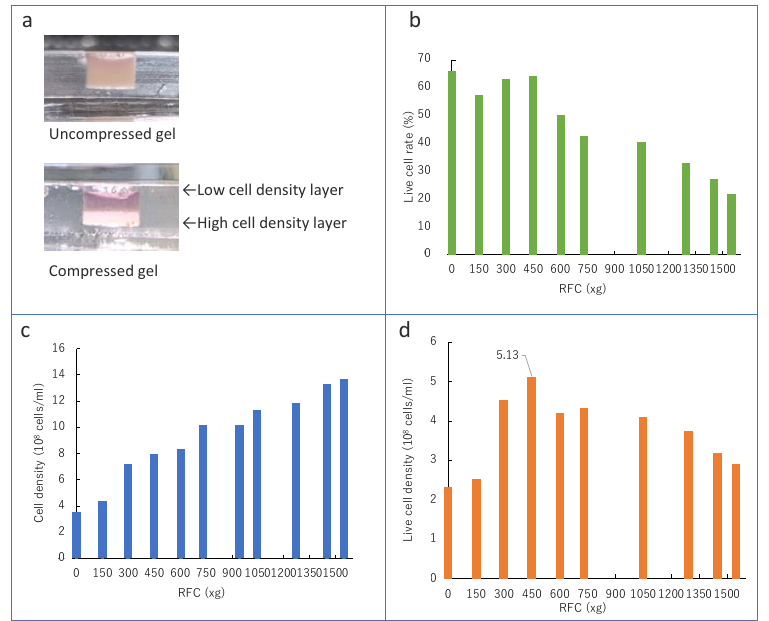
Figure 3. Effect of the centrifugal force on the cell: ( a ) high- and low-cell-density layers separated by the centrifugal force, ( b ) live cell rate changed by the centrifugal force, ( c ) cell density changed by the centrifugal force, ( d ) live cell density inside high cell density changed by the centrifugal force. Compressibility and cell viability were investigated and evaluated to examine the effect of the centrifugal force on cells. The cell compressibility was evaluated by